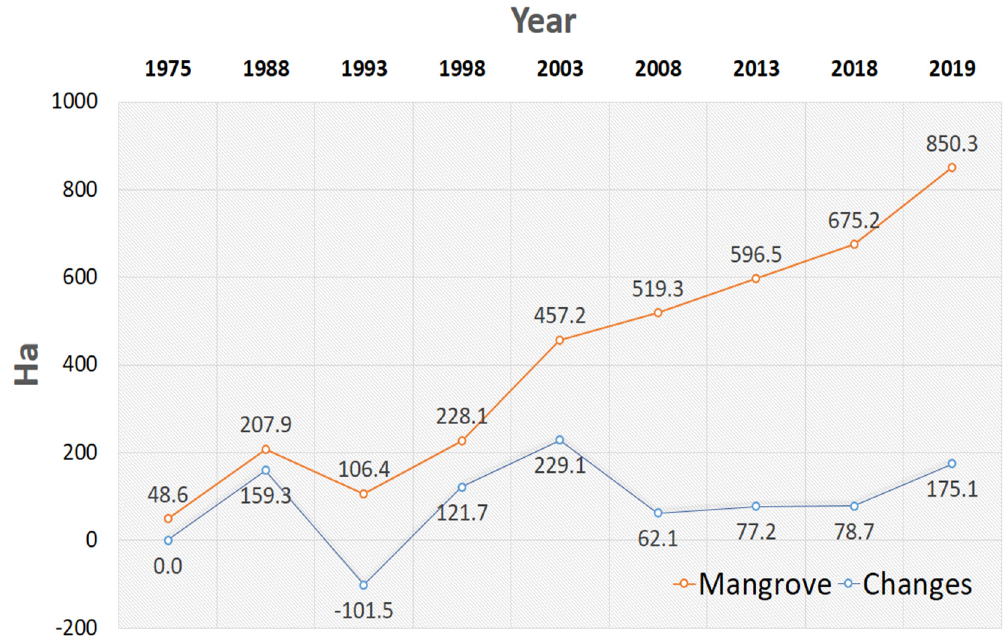
Figure 8. Total mangrove area (orange line) and changes in extent (blue line) (ha) from 1975–2019 in Thuy Truong commune.